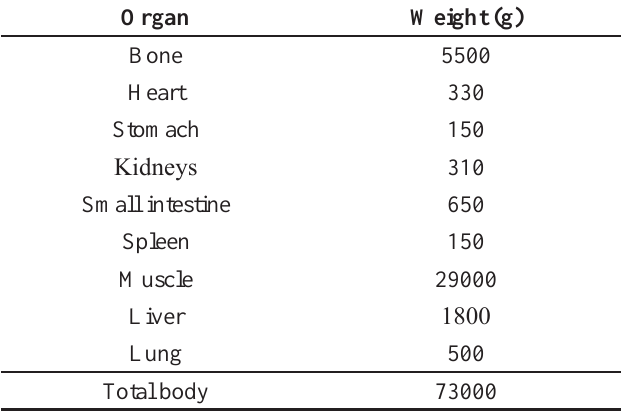
TABLE I - The mean weights of organs for human with